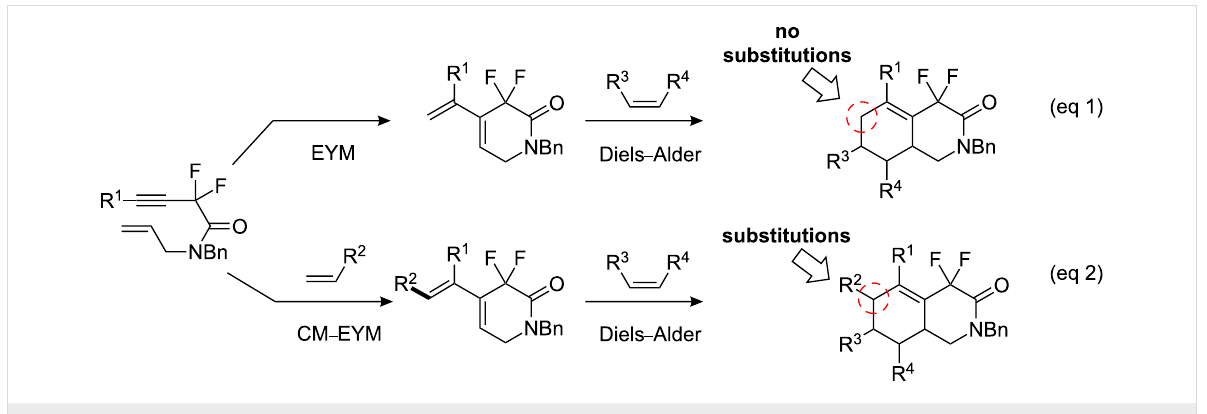
Scheme 2: Synthetic concept toward multi-substituted gem -difluoroisoquinolinones.